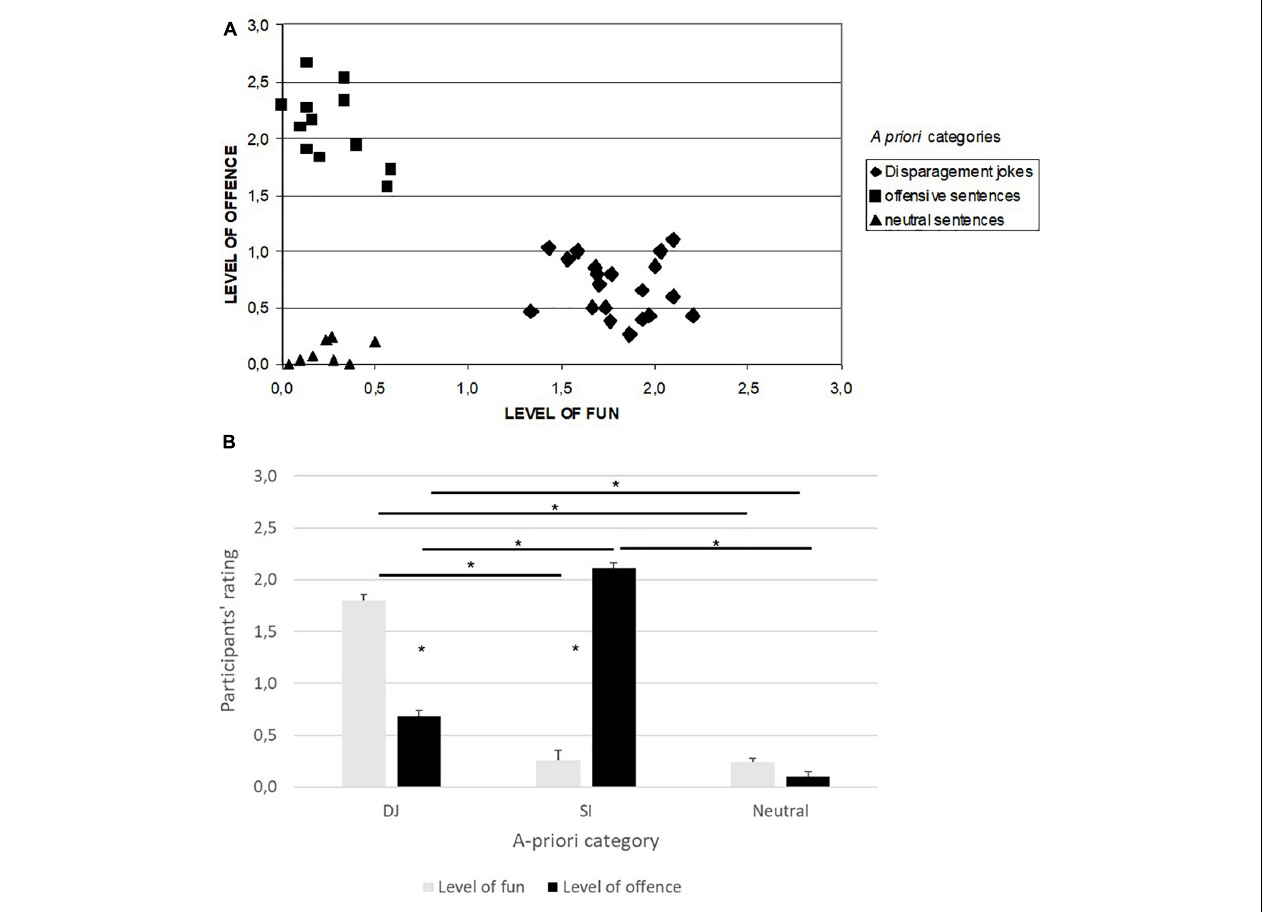
FIGURE 2 | Stimulus rating given by the thirty participants along two dimensions: fun and offensive. (A) Each point represents the average of the answers given by the subjects for each of the forty stimuli for the two dimensions. Different symbols indicate the three a priori classes of the presented stimuli: Neutral (triangle) and Offensive (square) sentences, and Disparagement Jokes (rhombus). (B) Participants’ rating on the level of fun and offense in the three a-priori categories. *indicate significant